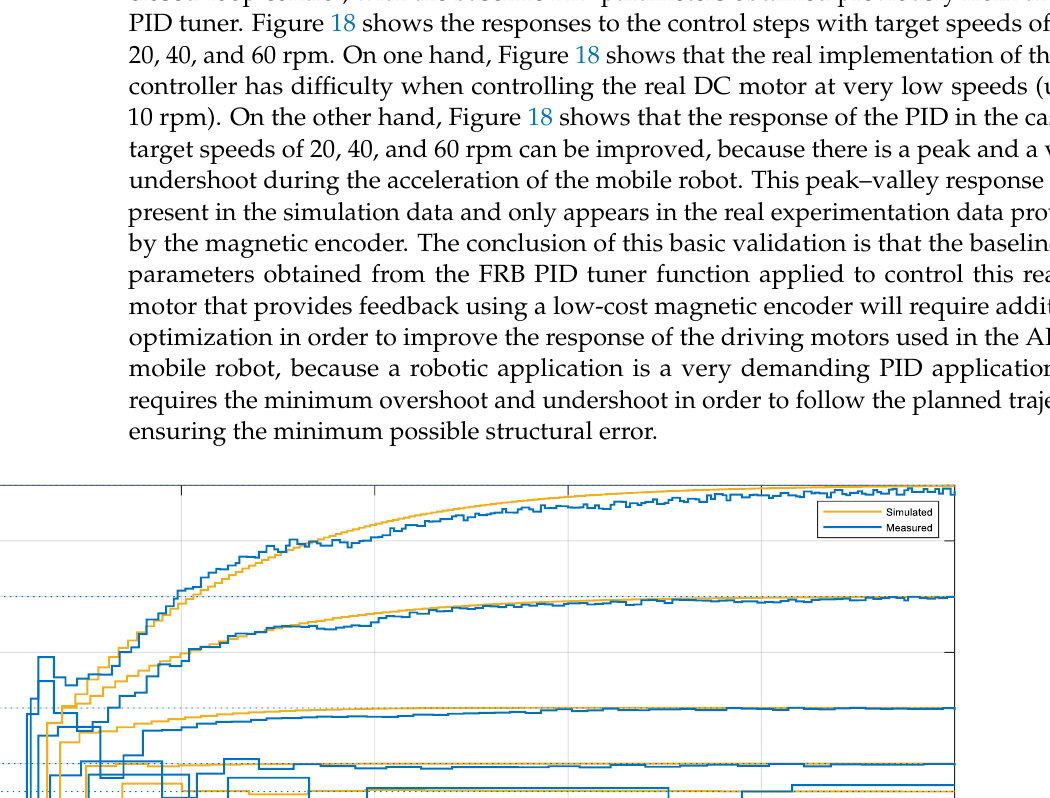
Figure 17. Simulink ® discrete control loop model used by the FRB PID tuner.